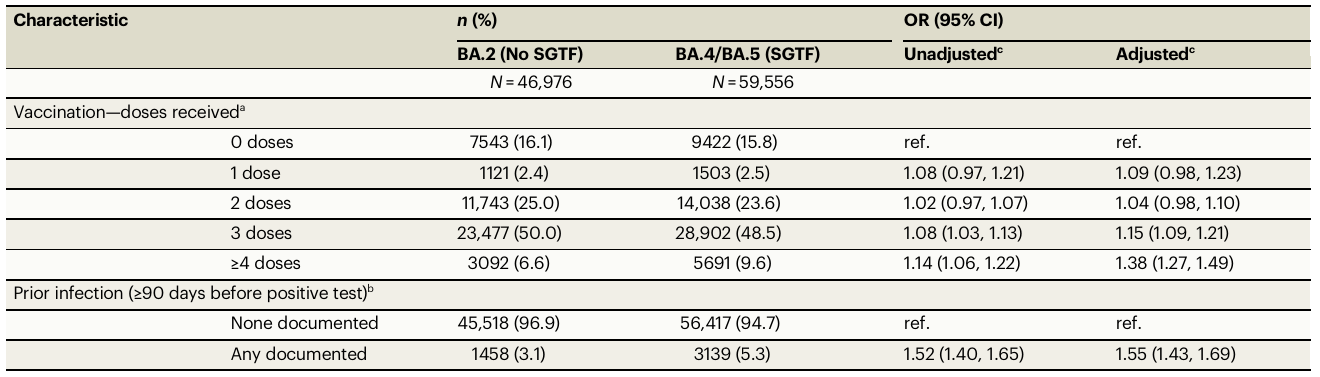
Table 2 | Prior vaccination and documented SARS-CoV-2 infection among cases with BA.2 and BA.4/BA.5 lineage SARS-CoV-2 infection Characteristic